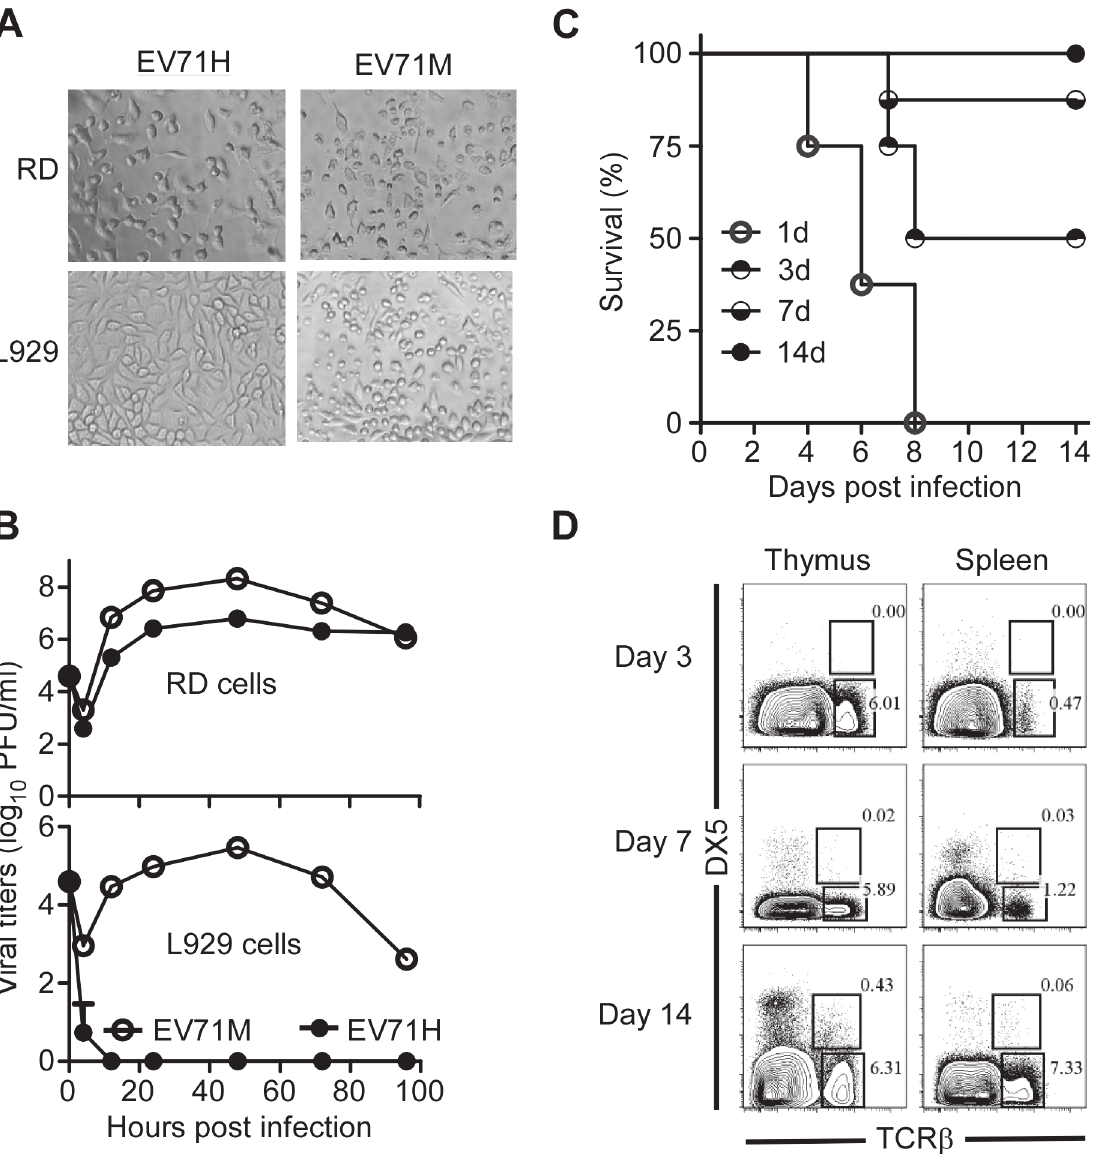
Figure 1. Age-dependent susceptibility of suckling mice to EV71 infection correlates with the immaturity of their immune system. (A) Cytopathic effects in human RD cells and murine L929 cells after infected with the parental human isolate EV71H and mouse-adaptive EV71M. (B) Replication kinetics of EV71H and EV71M in RD and L929 cells. (C) The survival rates of 1-, 3-, 7-, and 14-day-old ICR mice (n = 8, per group) after being infected with 2×10 6 PFU of EV71M. (D) The proportions of NKT and T cells in the thymus or spleen of young mice aged 3, 7 and 14 days. Splenocytes were stained with TCR β , DX5 and DAPI. TCR β versus DX5 profiles are shown for live cells (n = 4 – 8). Data are representative of three (A, B, C) or two (D) independent experiments.